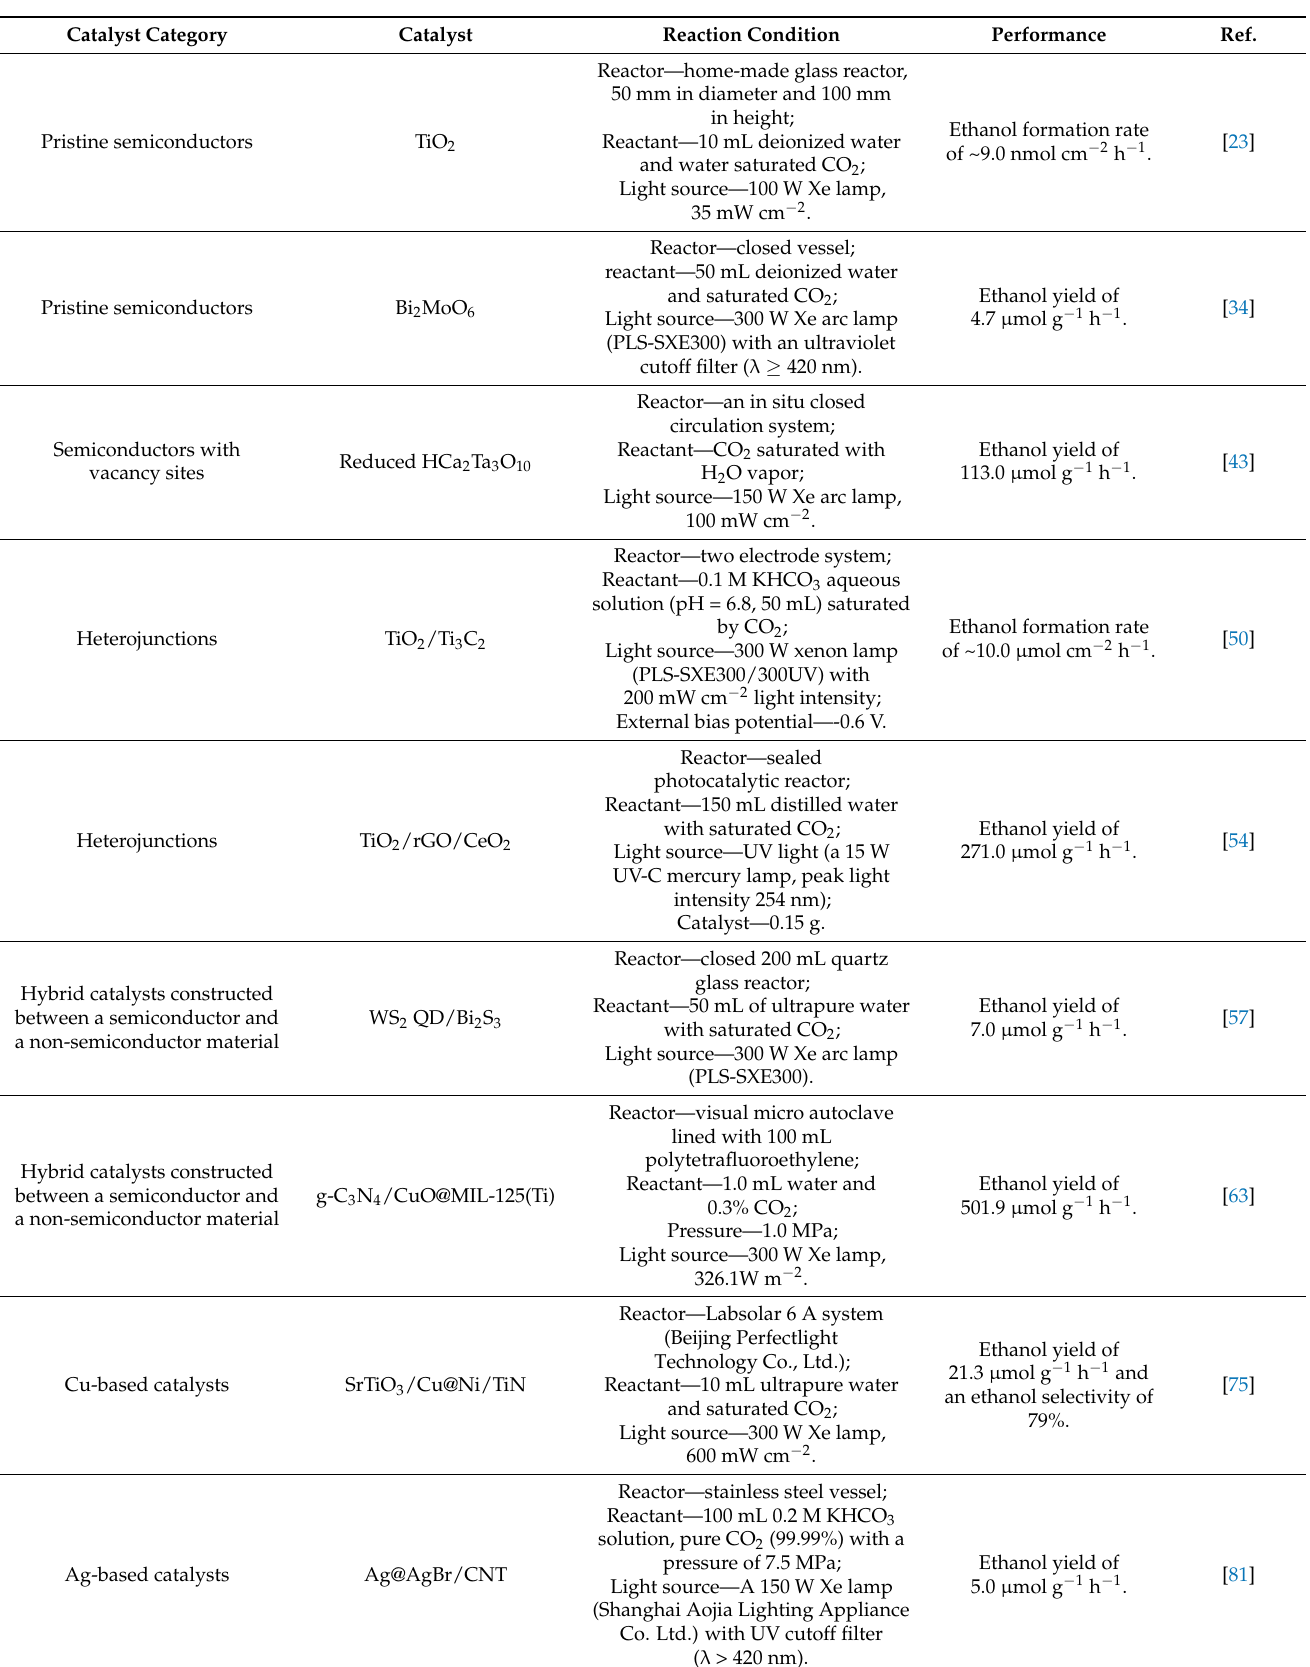
Table 1. Brief summary of some typical catalysts for photocatalytic CO 2 reduction to